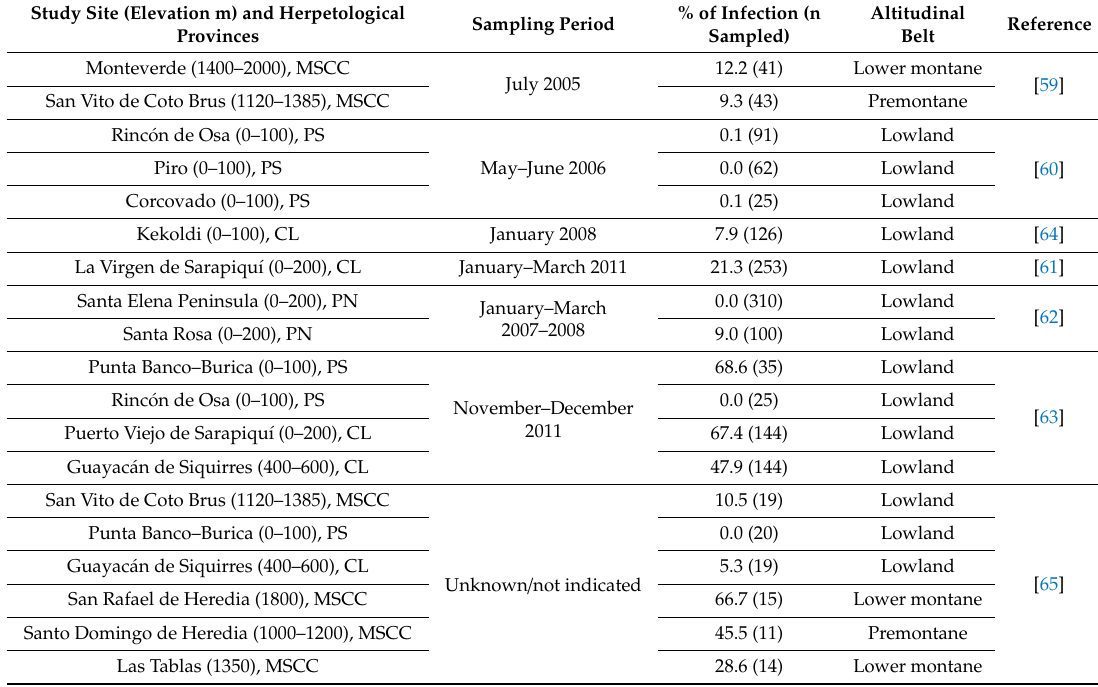
Table 1. Summary of studies where Batrachochytrium dendrobatidis ( Bd ) was detected in multi-species amphibian assemblages using conventional PCR and quantitative PCR (qPCR) in Costa Rica